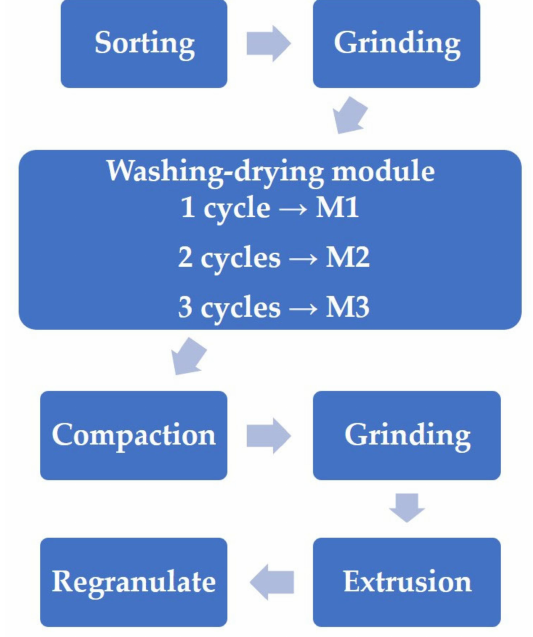
Figure 1. General scheme of the recycling line, from which wastes were collected.